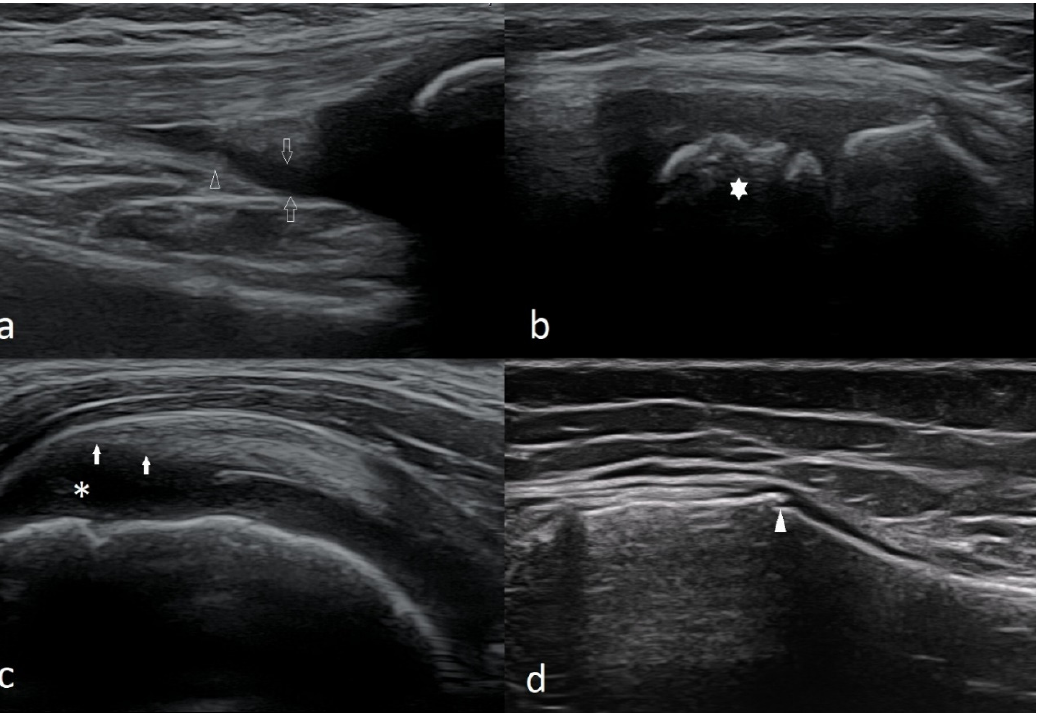
Figure 5. Examples of images of healthy children that could indicate a pathology in adults. ( a ) Suprapatellar recess in a healthy 5-year-old girl. Linear probe 3–12 MHz. Empty arrows—small amount of fluid; open arrowhead—small synovial fold. ( b ) Normal secondary ossification center of the medial tibial condyle (star) of a 9-year-old boy. The visible unevenness of the ossification center is not a pathology. Linear probe 3–12 MHz. ( c ) Attachment of the subscapularis tendon to the non-ossified lesser humeral tubercle (asterisk). Arrows—where tendon meets the outer surface of the tubercle. Linear probe 3–12 MHz. ( d ) Unevenness on the medial surface of the tibia in a 16-year-old girl in the place where there was a growth plate (between the proximal epiphysis and the shaft). Linear probe 3–19 MHz.